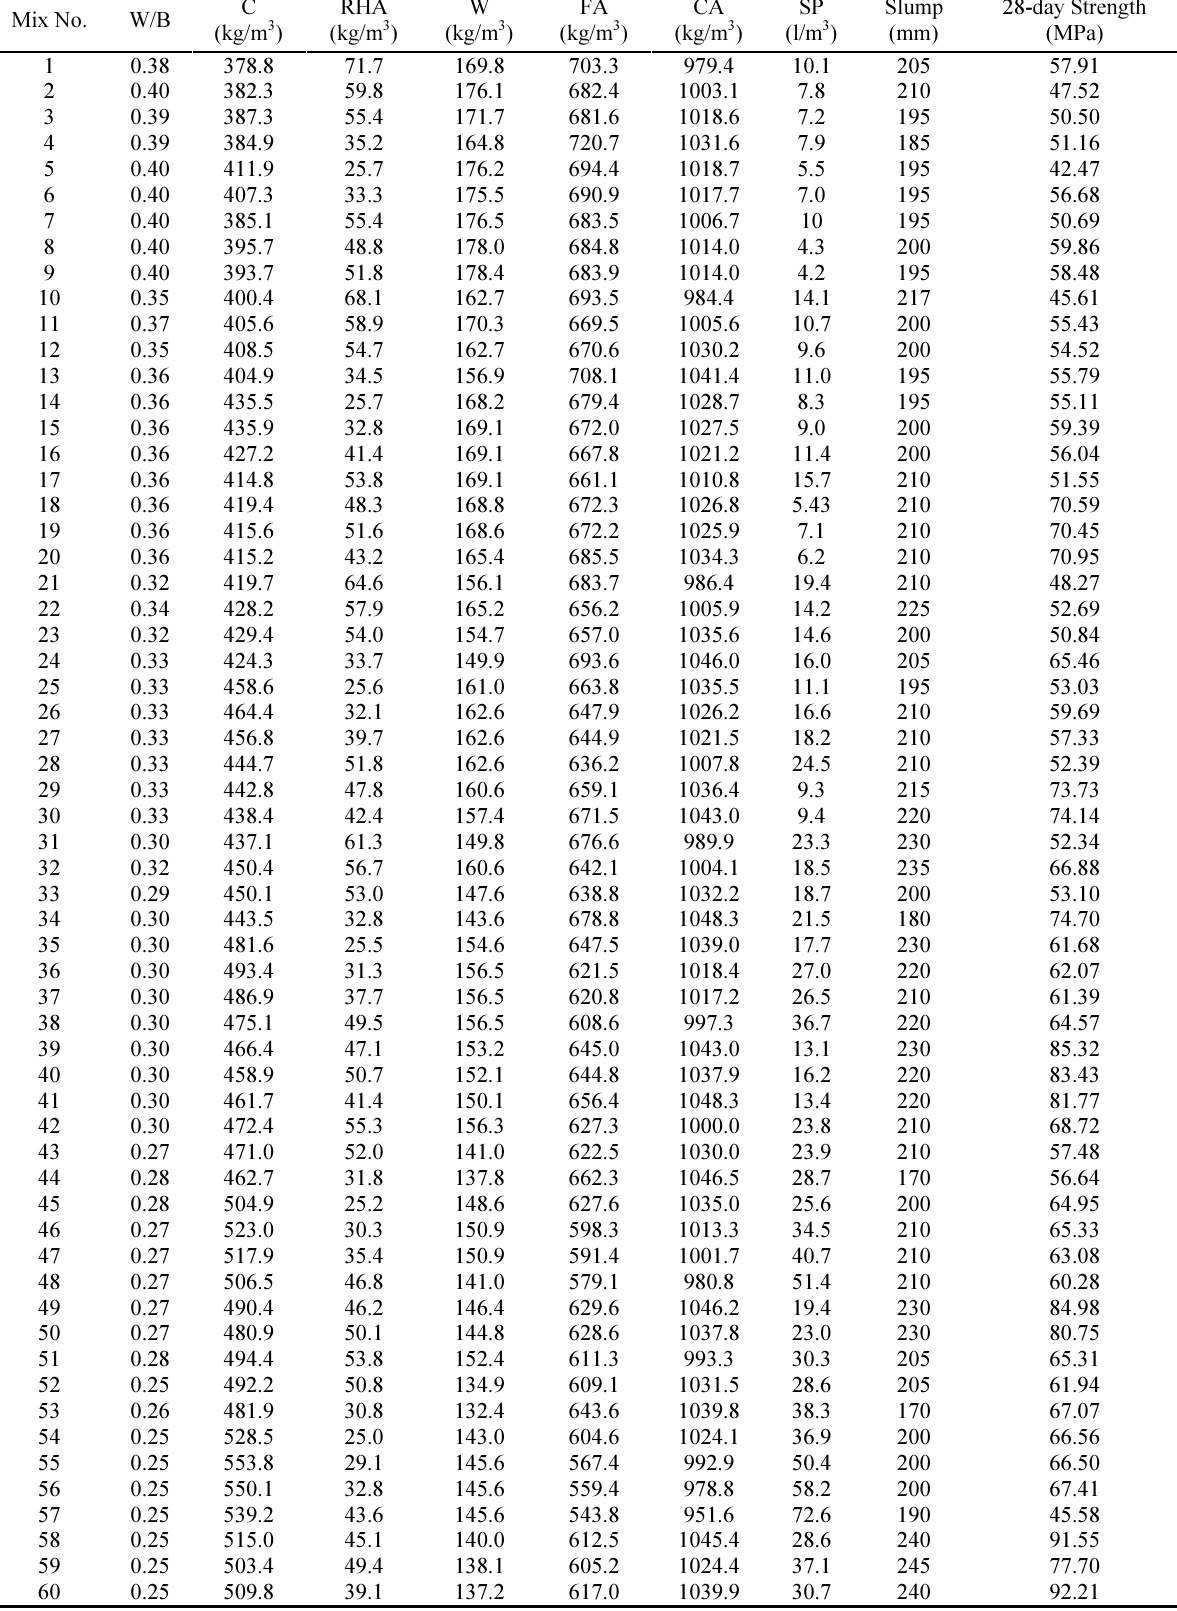
Table 3. Mix proportions, slump and 28-day compressive strength of RHA incorporated HPC Mix